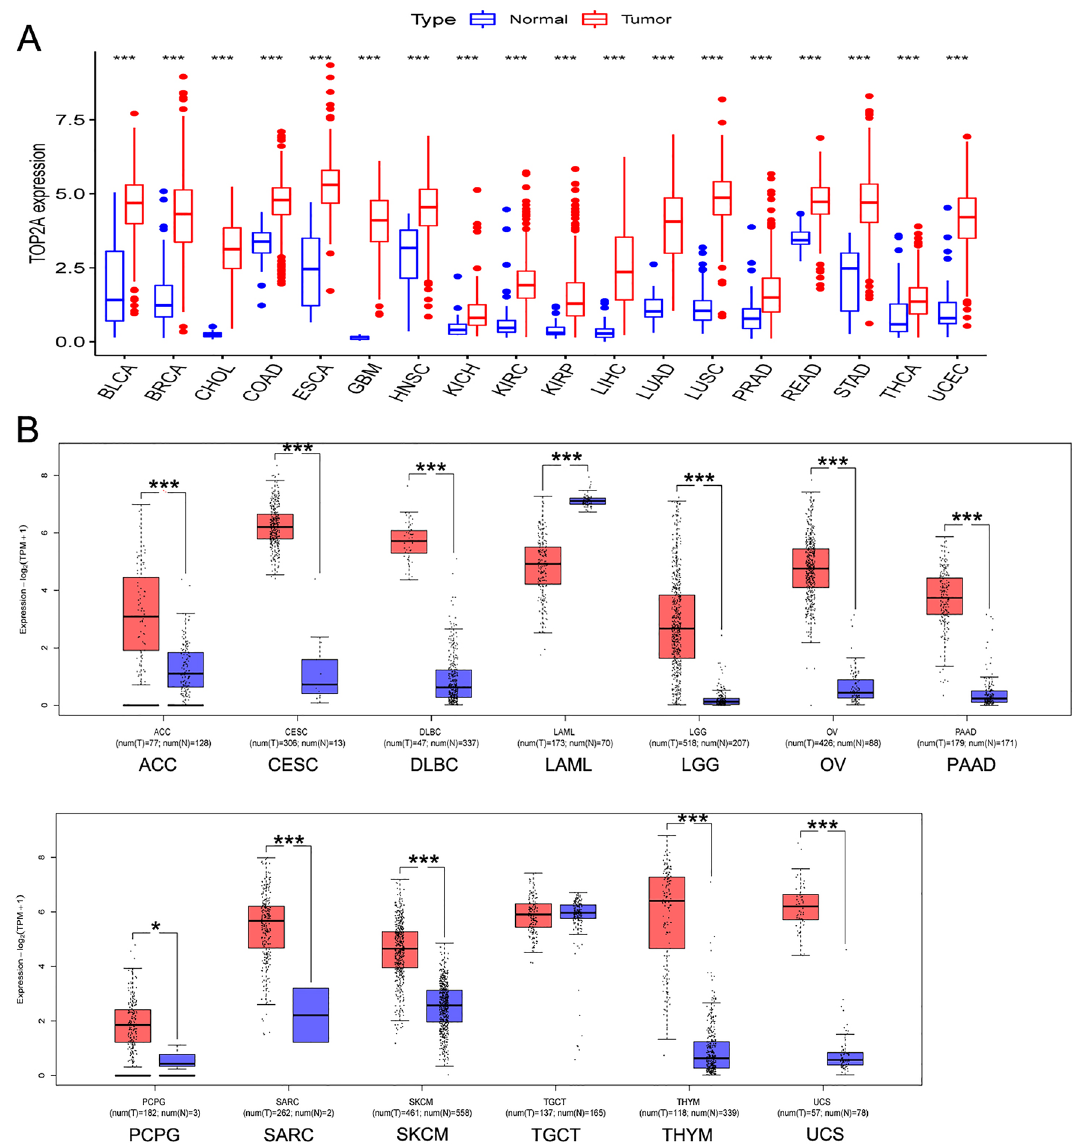
cancer types, normal tissues from GTEx project or TCGA + GTEx as controls. * p < 0.05, *** p <